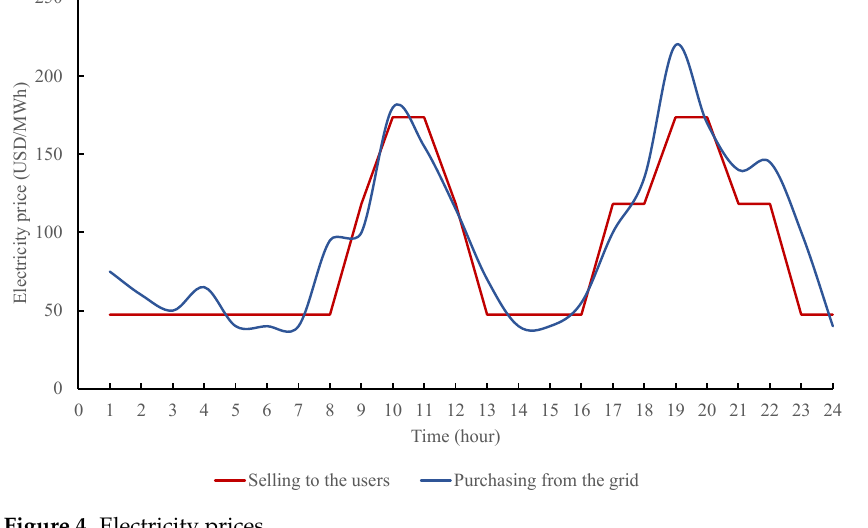
Figure 4. Electricity prices.